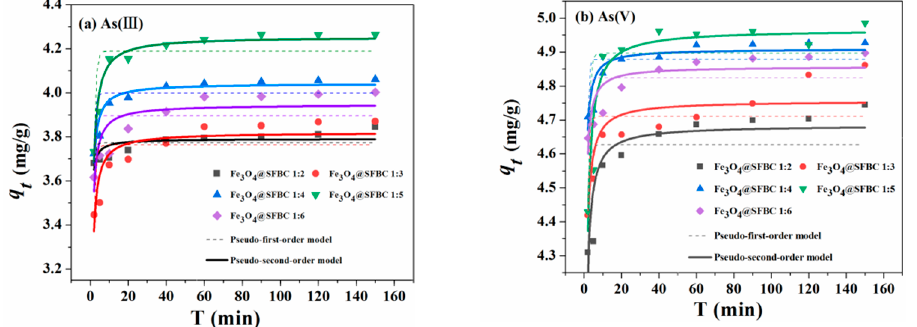
Figure 4. Adsorption kinetics of As( Ⅲ ) ( a ) and As ( Ⅴ ) ( b ) on Fe 3 O 4 @SFBC (prepared from biochar at different calcination temperatures) (experimental conditions: pH = 6 and 4, dose = 1 g/L, initial con- centration = 5 mg/L, T = 25 °C).